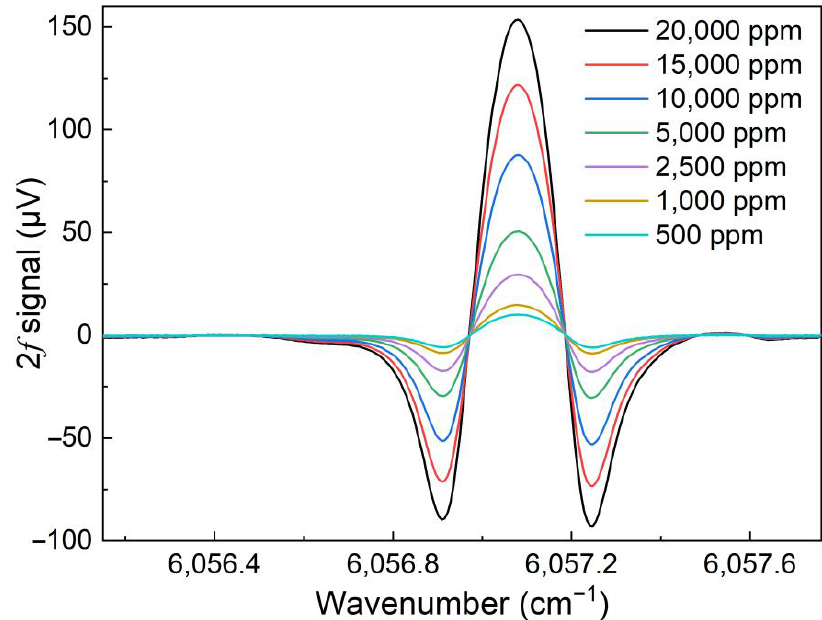
Figure 8. 2 f signal for CH 4 -QEPAS sensor with different CH 4 concentrations.